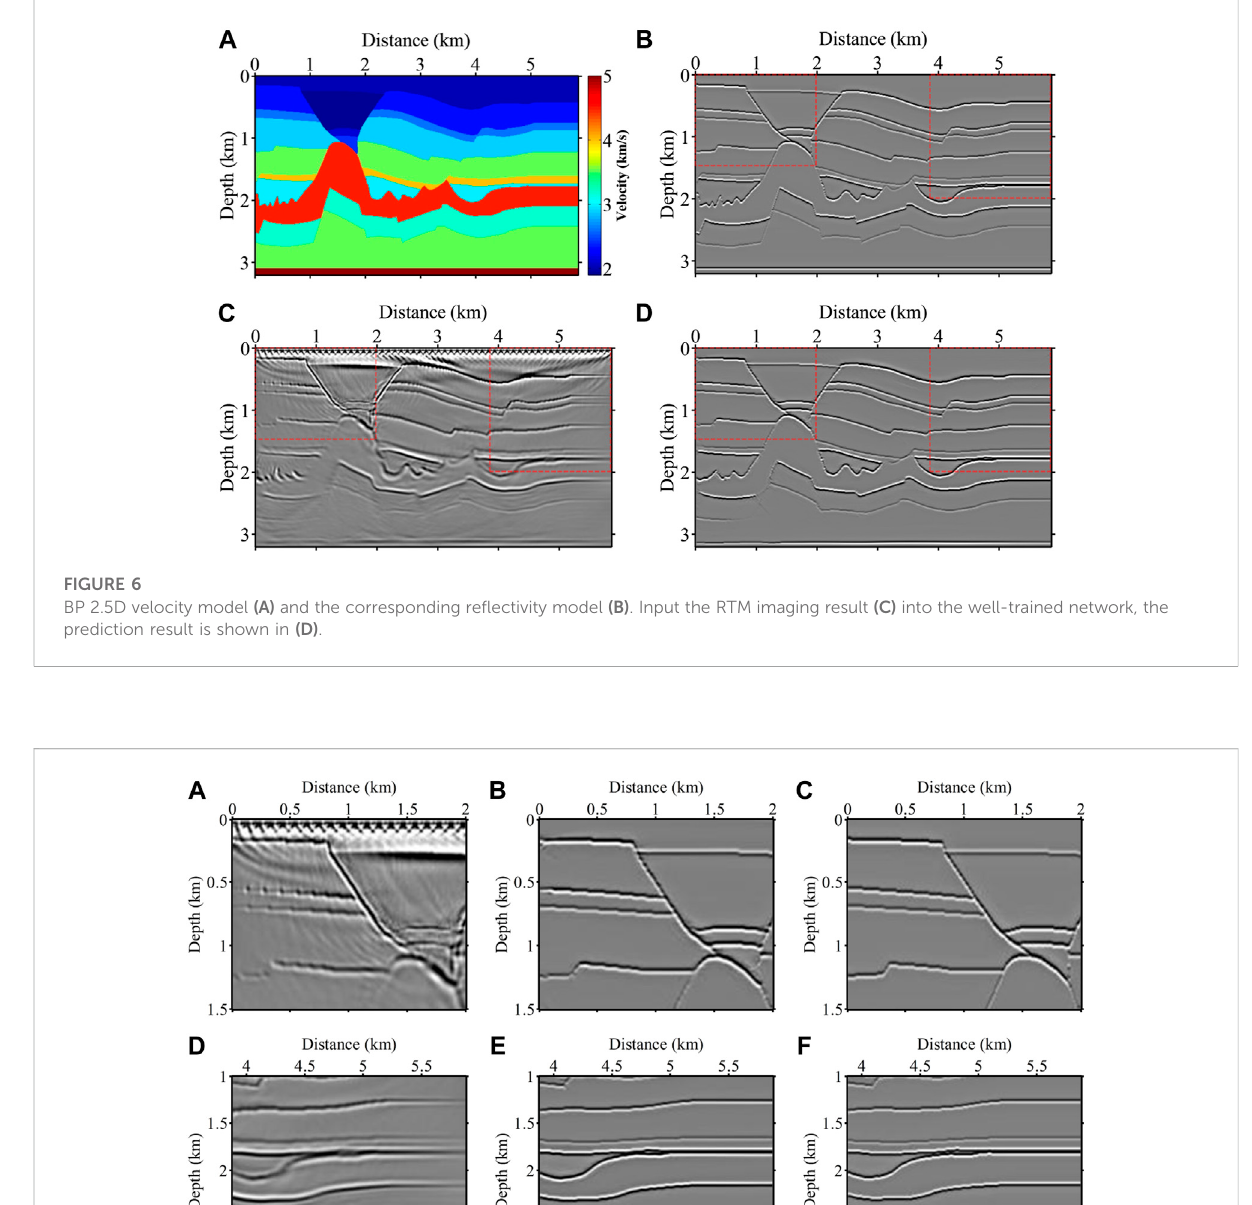
Figure 8B shows its corresponding re fl ectivity model. The imaging result obtained after fi nite-difference simulation and reverse time migration of Figure 8A is shown in Figure 8C. The